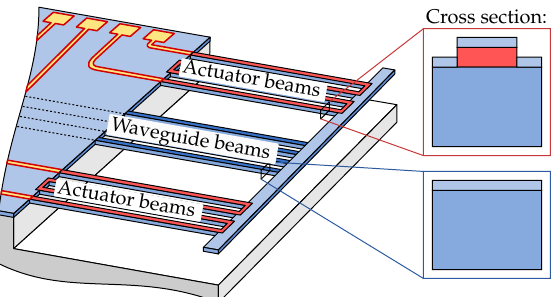
Figure C1. The layout of the measured arrays, indicating the cross-sections of the waveguide beams and the actuator